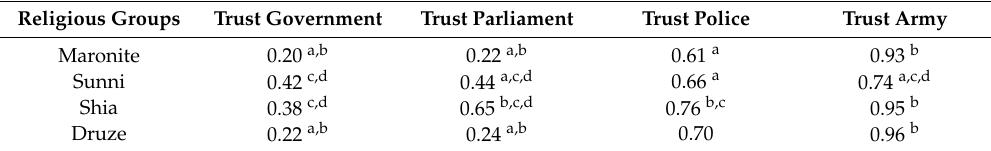
Table 6. Religious Group Mean Trust in Government Institutions.